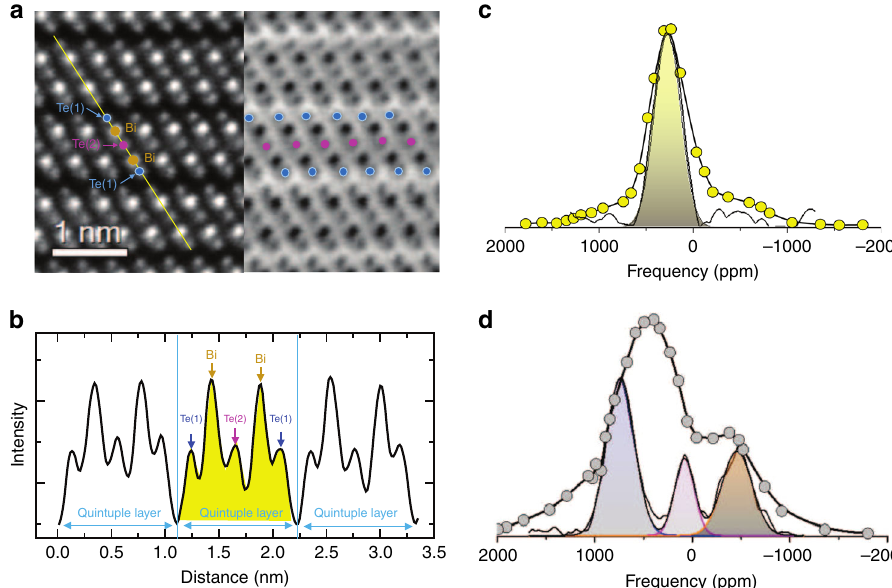
Fig. 2 Atomic scale TEM analysis and 1D 125 Te NMR. a Cross-sectional HAADF-ABF images of a Bi 2 Te 3 nanoplatelet. Brown, blue, and magenta dots indicate the Bi, Te(1) and Te(2) columns in the quintuplets. b The intensity pro fi le from the cross section (yellow line) in the HAADF image. c 125 Te static frequency sweep NMR (yellow circles) and the isotropic projection of the 2D 125 Te aMAT NMR at 14 kHz MAS (solid line) of bulk Bi 2 Te 3 . d 125 Te static frequency sweep NMR (gray circles) and the isotropic projection of the 2D 125 Te aMAT at 30 kHz MAS of a Bi 2 Te 3 nanoplatelets